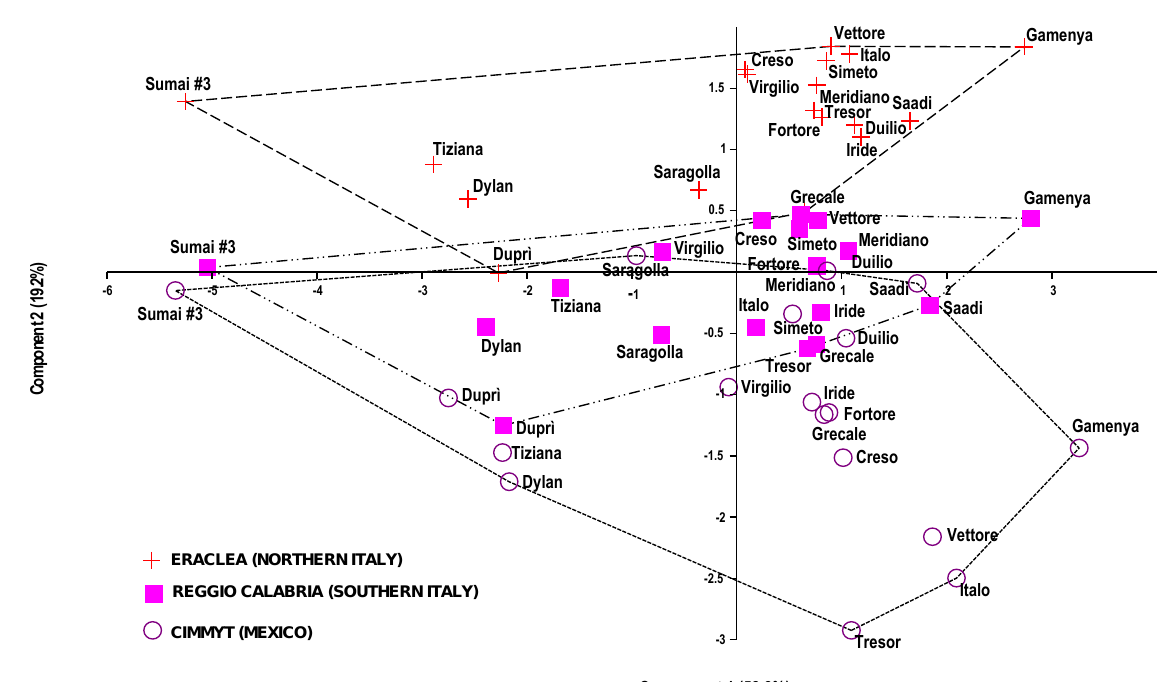
Figure 1. Scatter diagram resulting from principal component analysis (PCA), as defined by the first two principal components. Cultivars are clustered on the basis of similarity of disease susceptibility indices, phenological traits and qualitative grain features. They are grouped by site: Eraclea, Reggio Calabria (RC) and CIMMYT. Groups are delimited by convex hulls to highlight their respective trends.